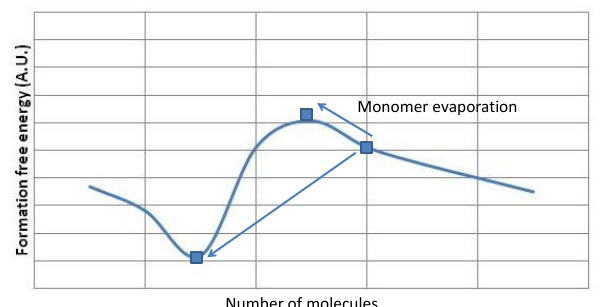
Fig. 6. Schematic representation of the effect of cluster fragmenta- tion in over-critical clusters acid